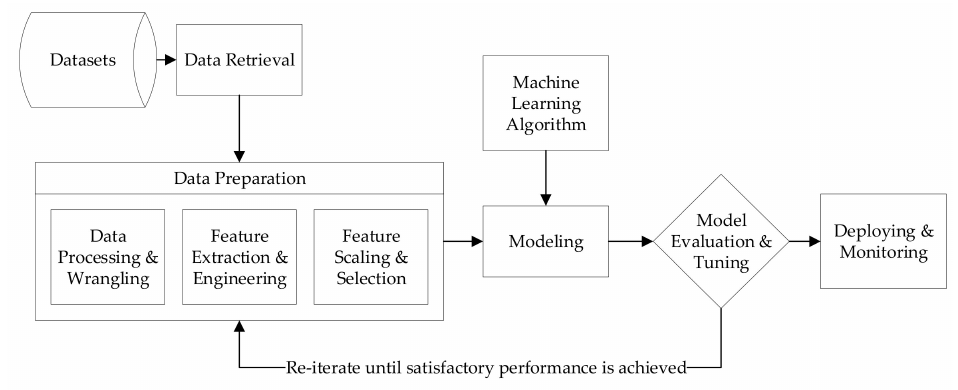
Figure 5. Traditional Machine Learning